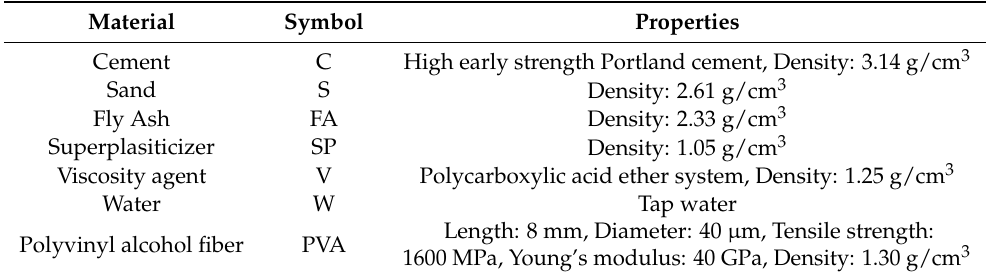
Table 2. Mix proportions of matrix.